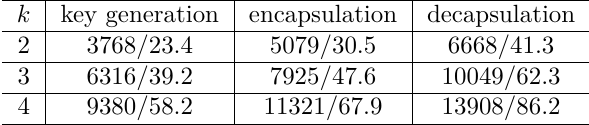
Table 3: Cycles counts/execution time ( µs ) of Kyber with different module dimension k at different protocol phases. Execution time is calculated at maximum frequency k key